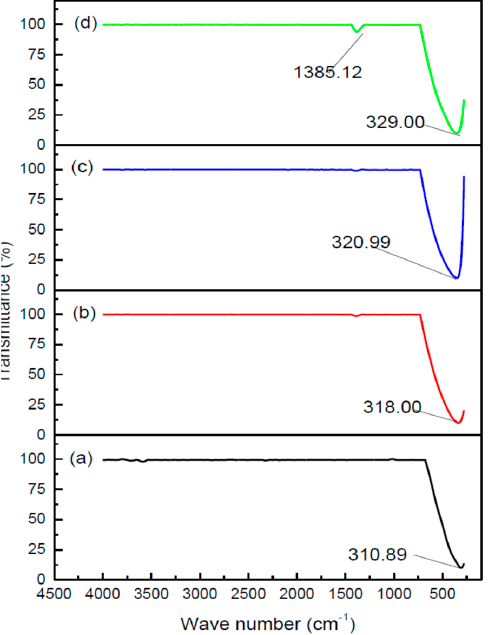
Figure 4. FT-IR spectra of CdO nanoparticles at PVP different concentration of ( a ) 0.00, ( b ) 0.03, ( c ) 0.04, and ( d ) 0.05 g/mL in the range of 280–4500 cm − 1 .